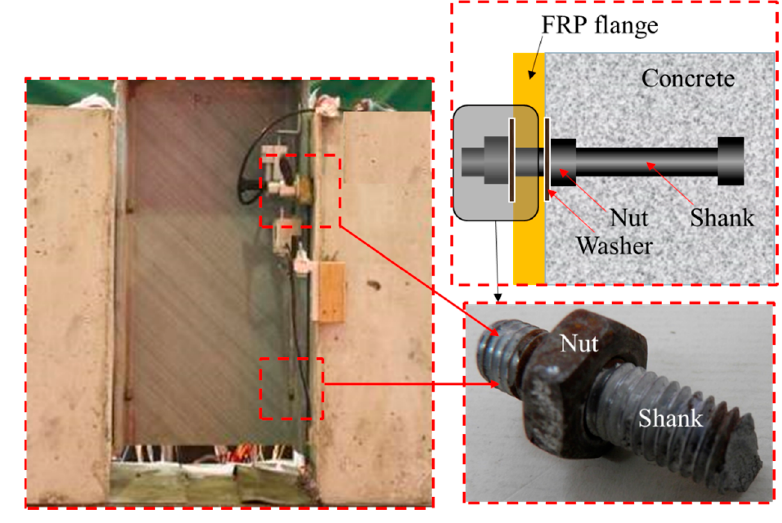
Figure 2. Typical failure mode for the push-out test specimens.